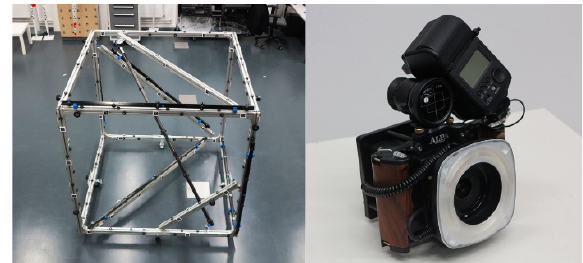
Figure 1. Left – VDI reference object, right – ALPA camera.